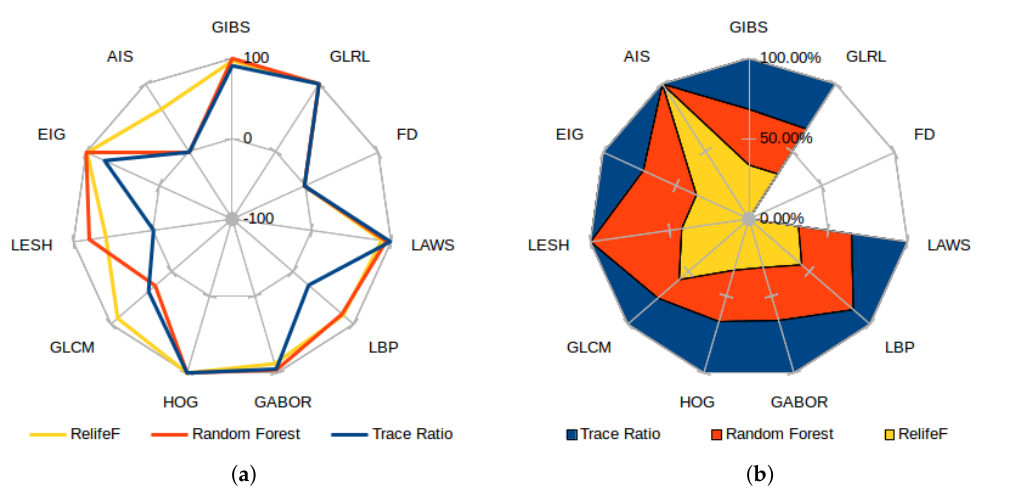
Figure 12. Best score attained for each feature category ( a ) and proportional feature relevance over maximum achieved position ( b ) for each feature selector.